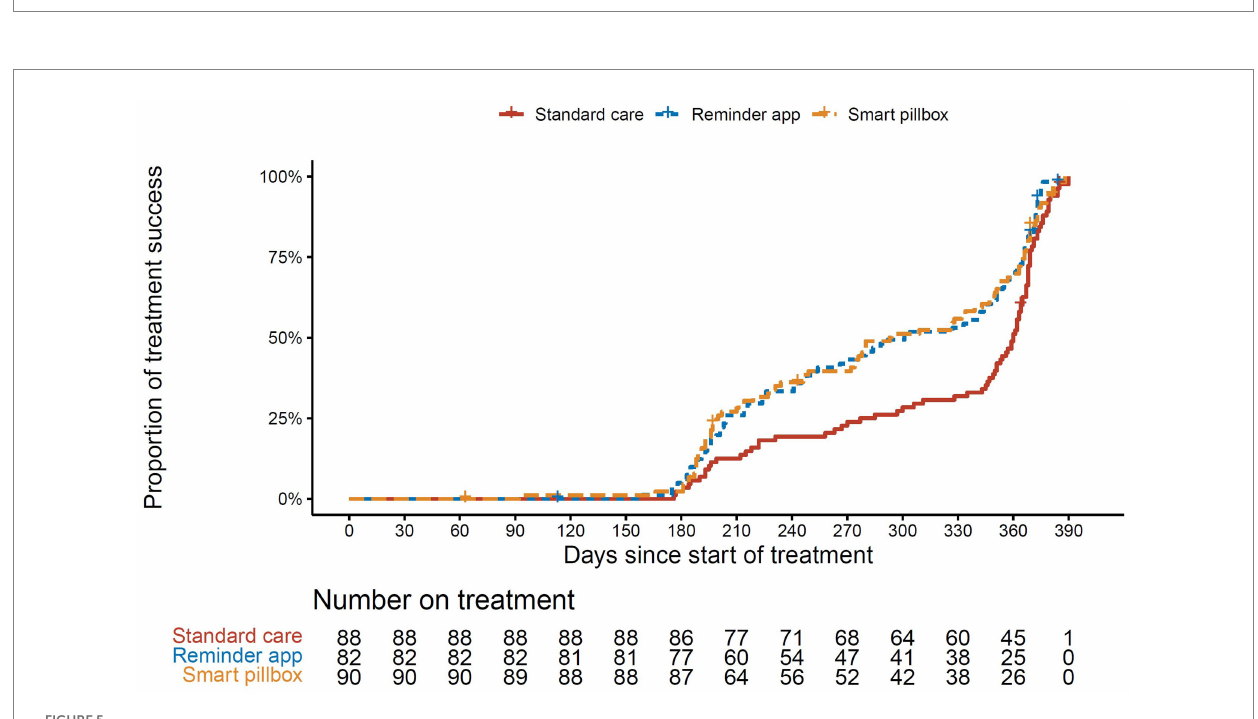
FIGURE 5 Kaplan–Meier survival estimates for treatment